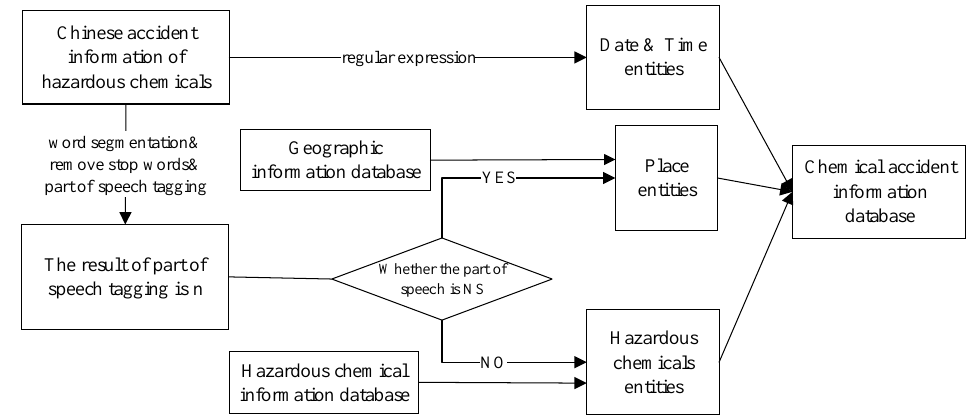
Figure 3. Named entity recognition process based on rule templates.